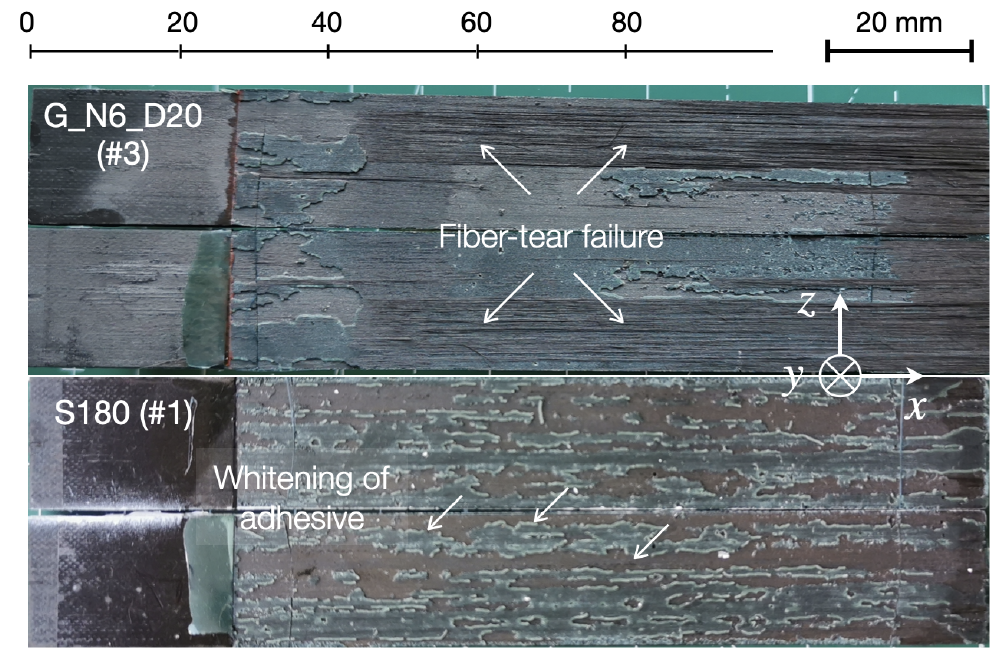
Figure 13. Fracture surfaces of the composite joints with grit-blasted and sanded